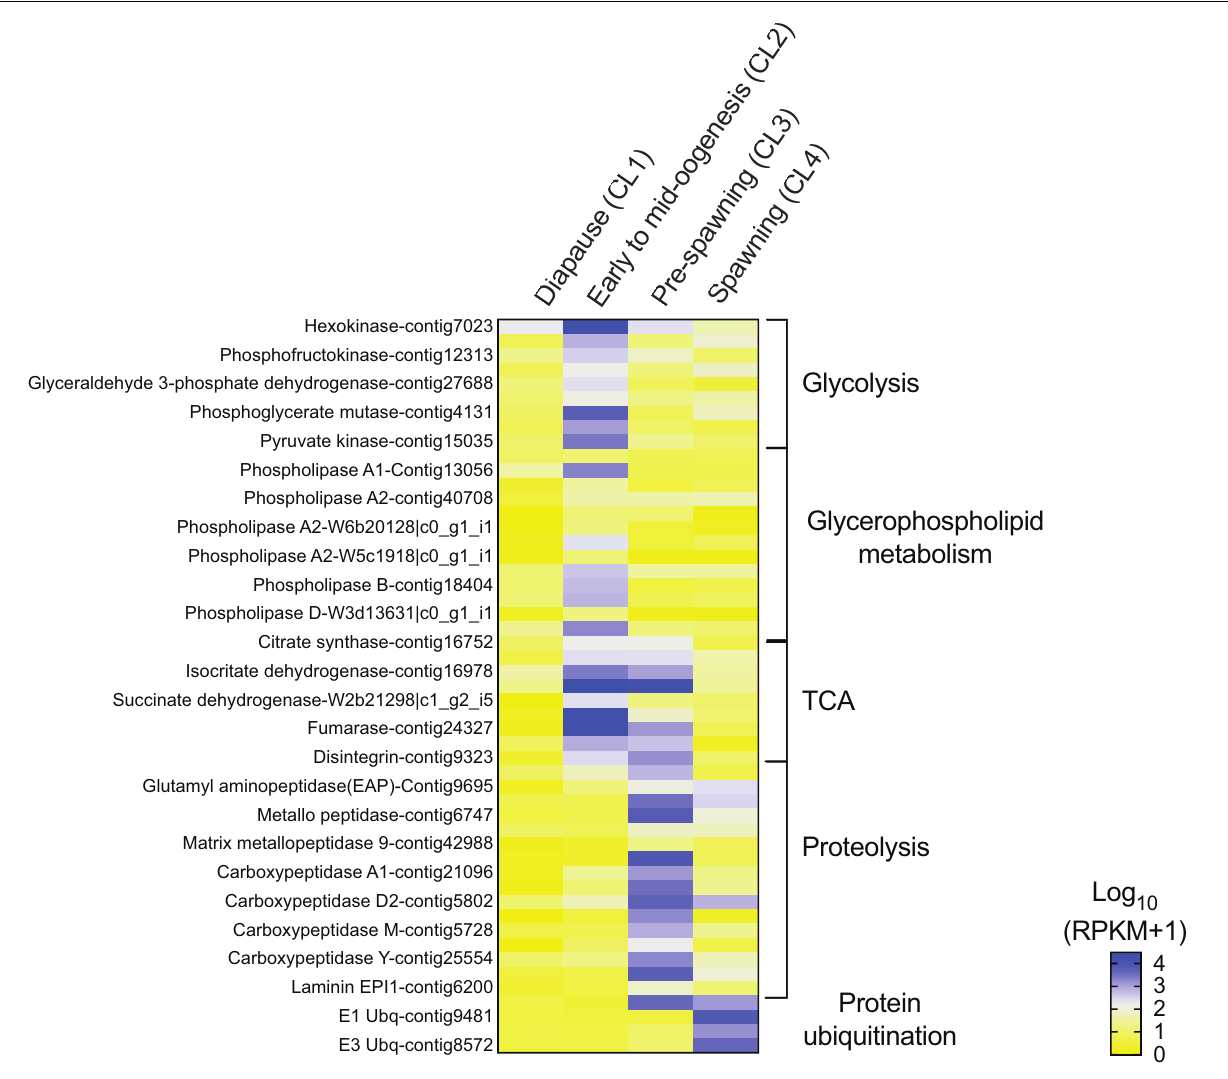
highly expressed in both pre- and spawning females (CL3 and CL4) ( Figure 4